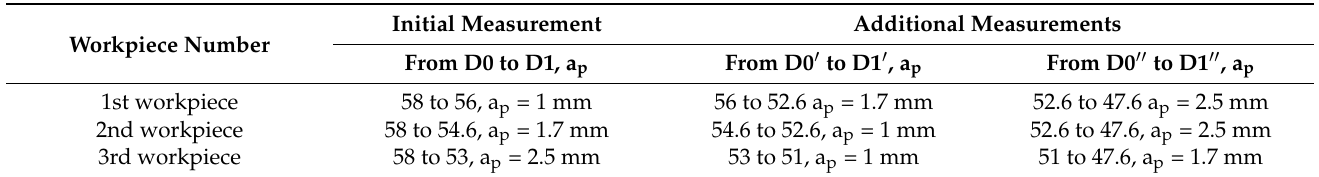
Table 3. Series of initial and additional measurements that were used to check the validity of